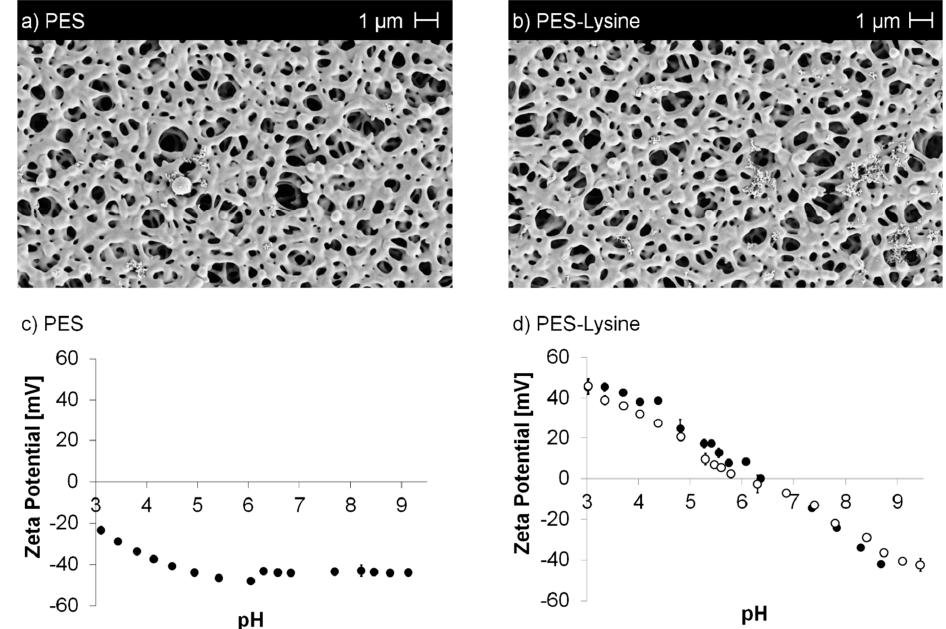
Figure 2. SEM images ( a , b ) of the pristine PES and PES–Lysine membrane as well as zeta potential vs. pH curves ( c , d ) of the pristine PES and PES–Lysine (before (full symbol) and after (open symbol) stability test) membrane.